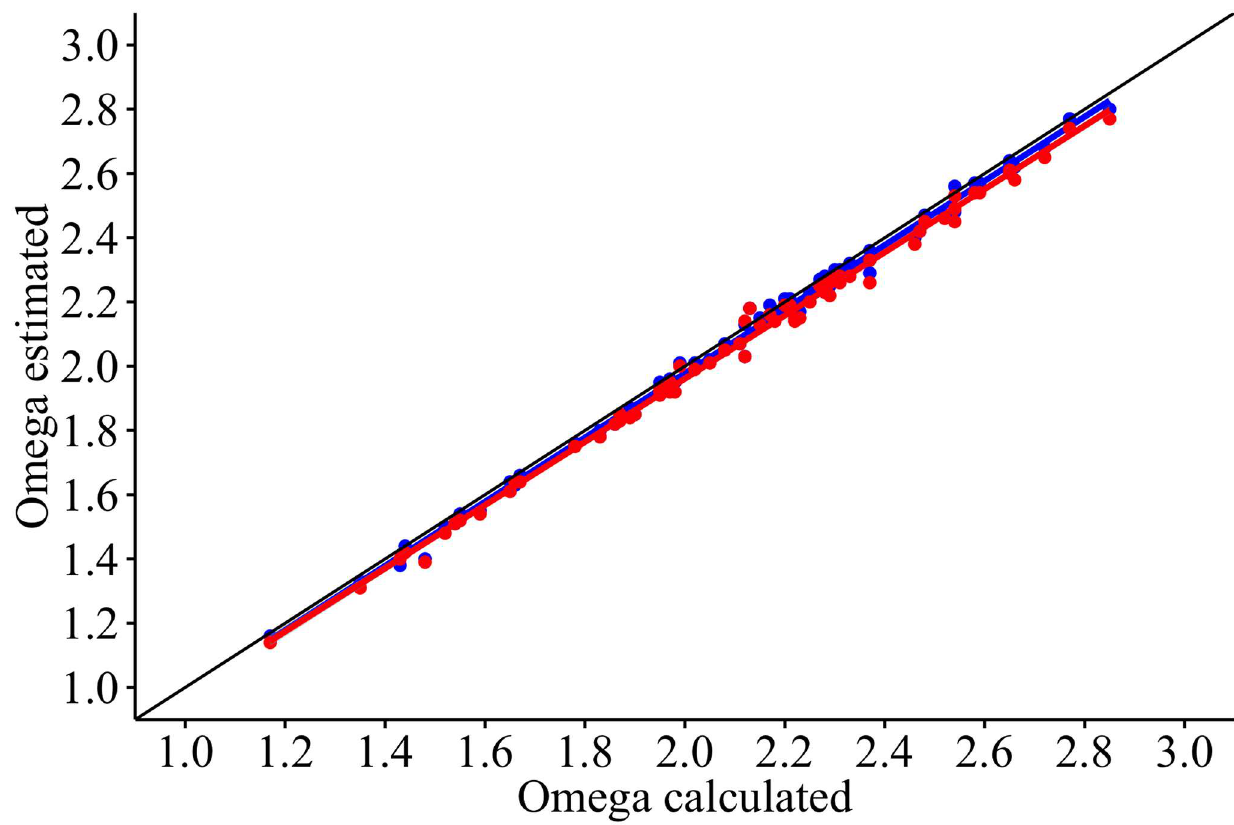
Fig 5. Relationship between calculated and estimated Ω Arag . The latter was approximated from measuredpH T and either TA est (blue points and line, r 2 = 0.996, y = 0.998x + 0.0271) or a regionalaverageTA (red points and line, r 2 = 0.996, y = 0.983x-0.0049). See text for